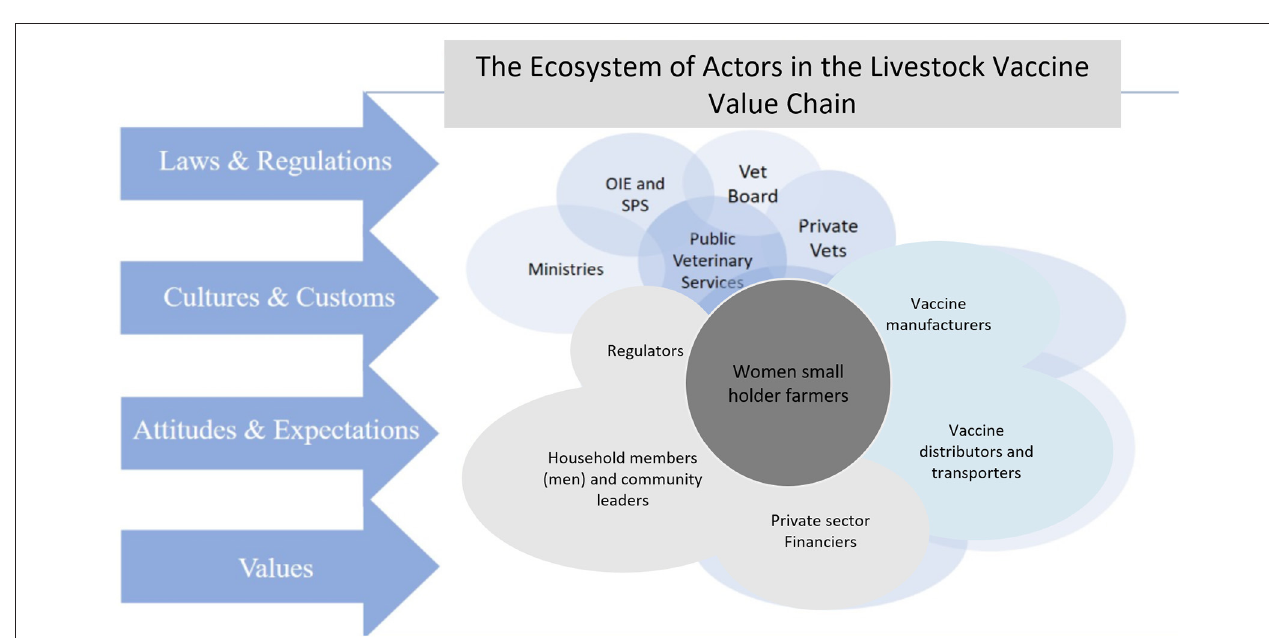
FIGURE 3 | The ecosystem of actors in the Rwanda livestock vaccine value chain.